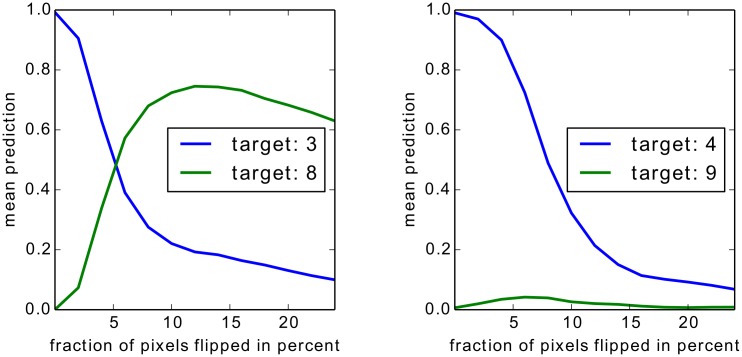
Flipping of pixels with negative responses, due to a pixel-wise decomposition for prediction targets 8 (for digits 3 on the left) and 9 (for digits 4 on the right).Pixels with lowest negative scores are flipped first.